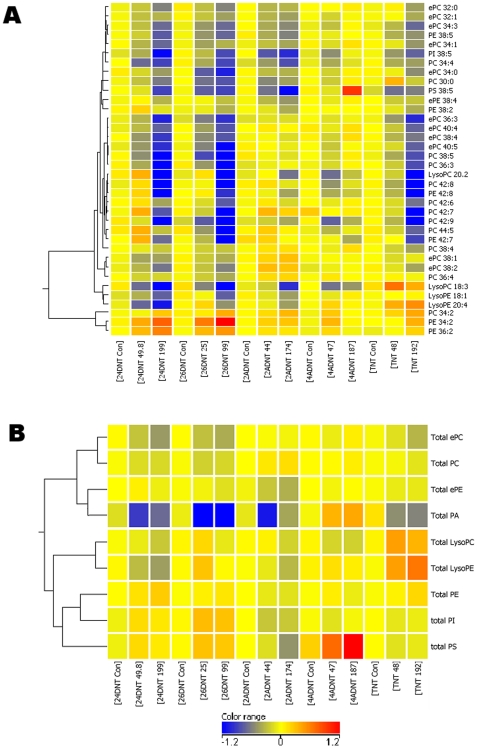
Hierarchical clustering of commonly significantly regulated lipid species in response to 2,4DNT, 2,6DNT, 2ADNT, 4ADNT and TNT.Rats were treated with 2,4DNT, 2,6DNT 2ADNT, 4ADNT or TNT with one of 3 doses including controls for each compound for 24 h. Rats were sacrificed and liver tissues were used for lipid extraction and lipid profile measurement as described in Materials and Methods. Actually the same samples were also used for the microarray studies. 36 individual lipid species (A) and 9 total lipid classes (B) that were significantly commonly regulated by at least 3 of the compounds. Significantly regulated individual lipid species or lipid classes were determined using One-Way ANOVA with a multiple adjust p value less than 0.05 across various doses of a compound.